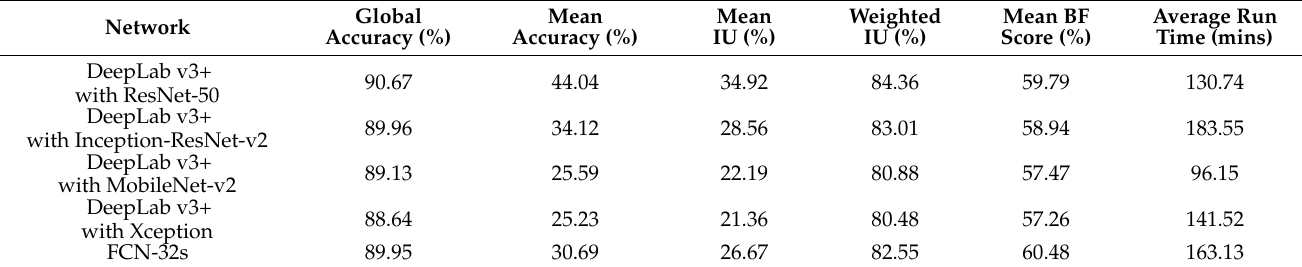
Table 3. Semantic segmentation performance and average run time results for DeepLab v3+ with